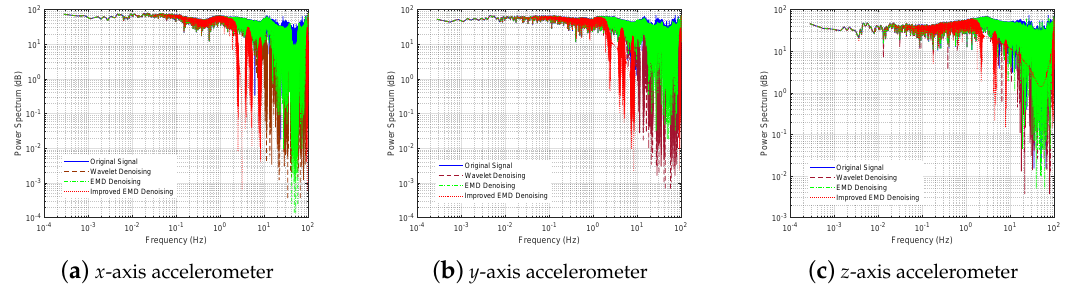
Figure 9. Power spectrum of accelerometers by utilizing multiple denoising